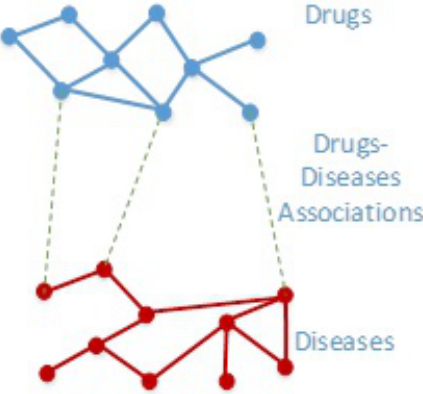
Fig. 1 Heterogeneous drugs-diseases network.